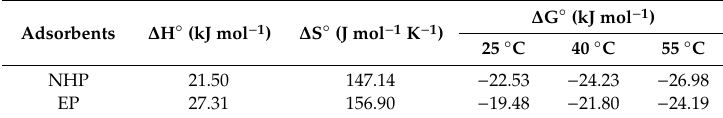
Table 4. Thermodynamic parameters for adsorption of EGCG onto processed pomelo peel at di ff erent temperatures.